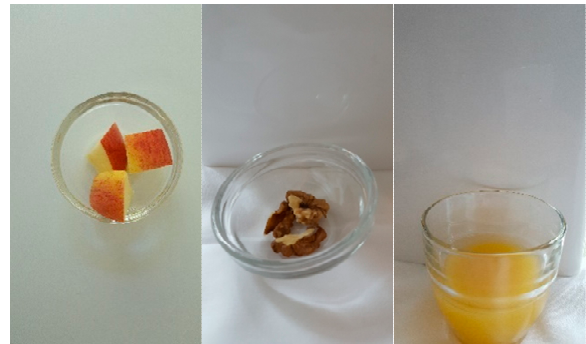
Figure 1. The color scale.